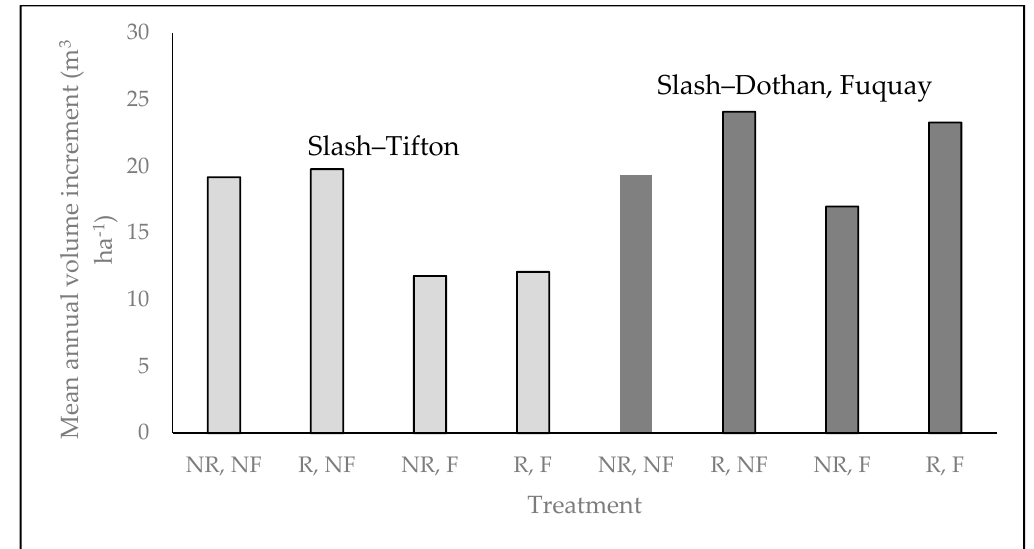
Figure 13. Mean annual volume increment over the five-year study period for slash pine by treatment [25]. Treatments: no rake, no fertilization (NR, NF); rake, no fertilization (R, NF); no rake, fertilization (NR, F); rake, fertilize (R, F) (refer to Tables 6 and 7 for study details, information on fertilizer treatments, and statistical test results).